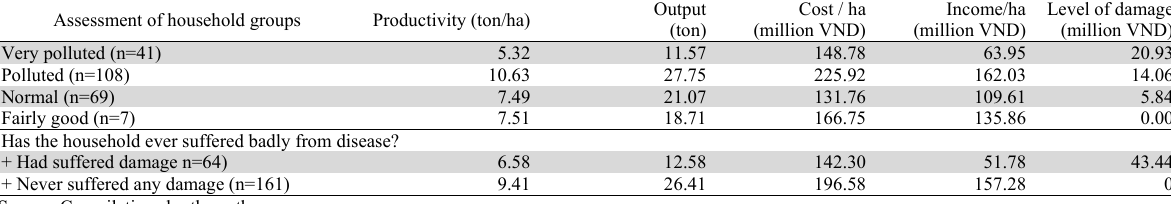
Table 1 Relationship between aquaculture results and pollution level by households’ assessment Assessment of household